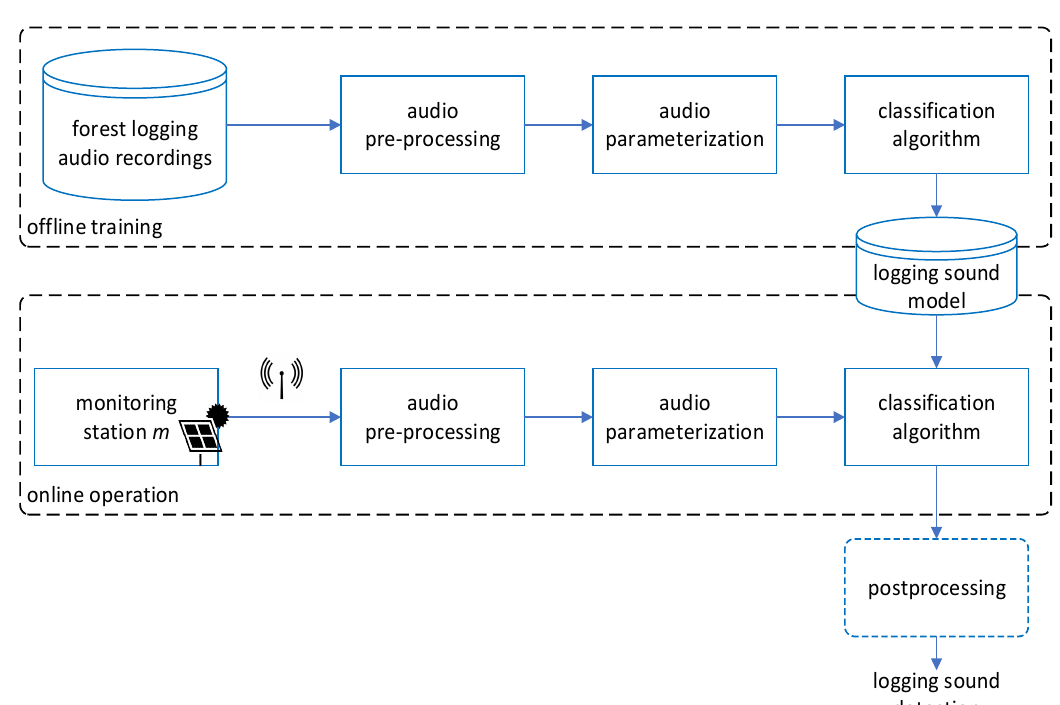
Figure 2. Block diagram of the audio processing and logging sound classification.